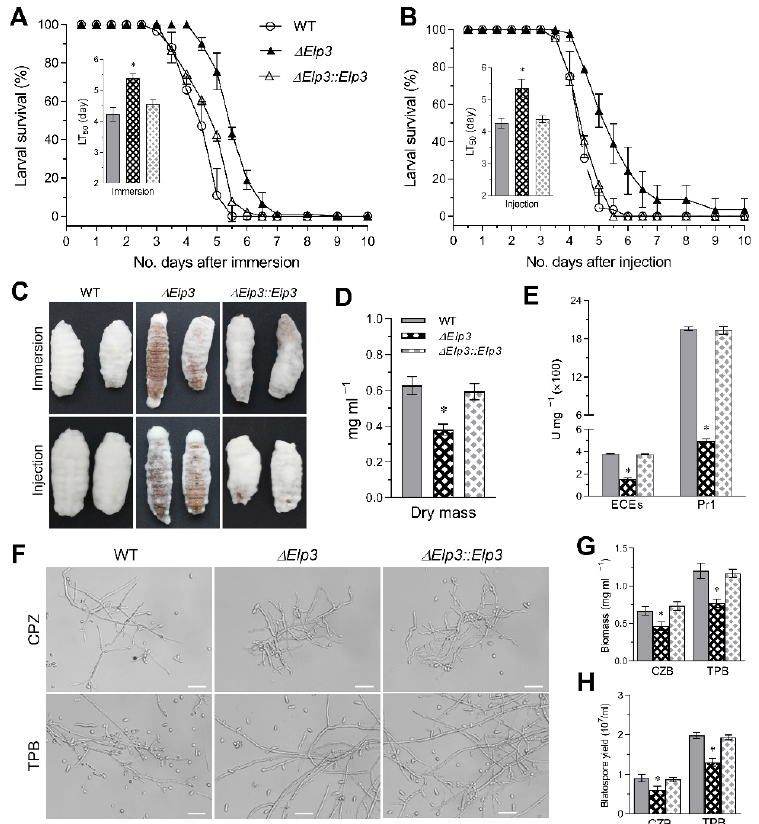
Figure 4. Impact of Elp3 on B. bassiana virulence and virulence-related properties. ( A , B ) Insect bioassay survival curves and calculated LT 50 values using the greater wax moth ( G. mellonella ) larvae as hosts after topical application (immersion) and intra-hemocoel injection, respectively. ( C ) Repre- sentative images of fungal outgrowth on the surfaces of cadavers 4 d post death. ( D , E ) Quantification of fungal biomass, total extracellular protease (ECEs), and Pr1 protease activities after 3 d growth in CZB-BSA. ( F ) Representative microscopic images of submerged hyphae and blastospores after 3 d growth in CZB and TPB. Scale bars = 20 µ m. ( G , H ) Fungal biomass levels and blastospore yields quantified after 3 d growth in CZB and TPB. Asterisk indicates significant difference ( p < 0.05) from unmarked (Tukey’s HSD). Error bars: SD from three technical